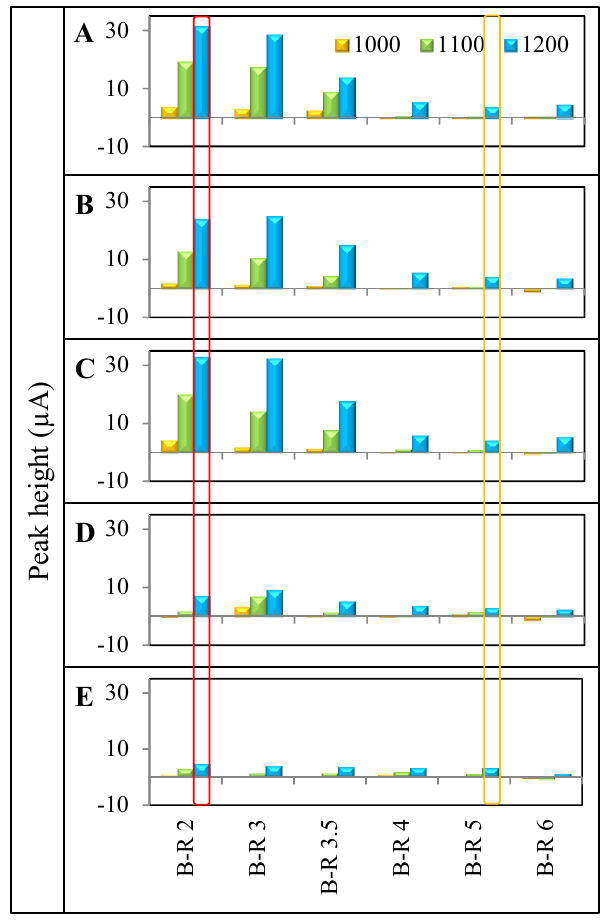
Figure 3. Expression of ideal potentials (range 1000–1200 mV) in buffers Britton-Robinson buffer (B-R) with pH 2–6 for each of PGEs obtained from HDVs. All maximums were carried out with PGEs concentration of 10 µg.mL − 1 . Ideal potentials for ( A ) oxaliplatin; ( B ) cisplatin; ( C ) carboplatin; ( D ) PtCl potential and pH buffer for determination of platinum-based cytostatics from platinum chlorides is highlighted with red color. Potential and pH buffer, characterizing concentration of platinum in sample is highlighted with